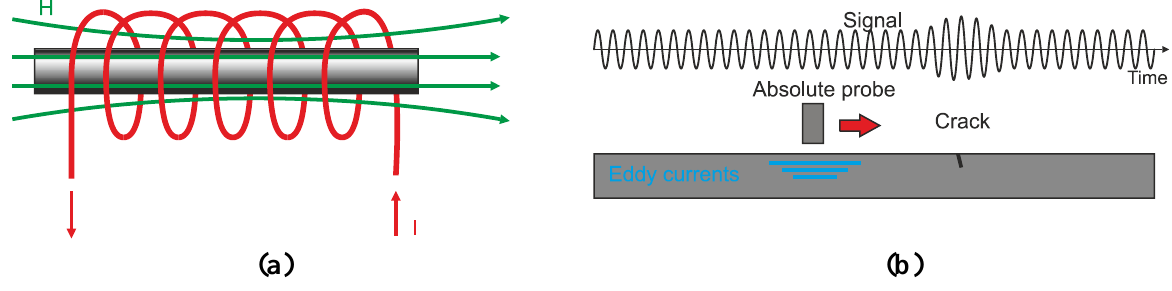
Figure 21. (a) Non-compensated absolute encircling coil probe. (b) Absolute signal from non-compensated absolute encircling coil probe when a cracked bar is tested.